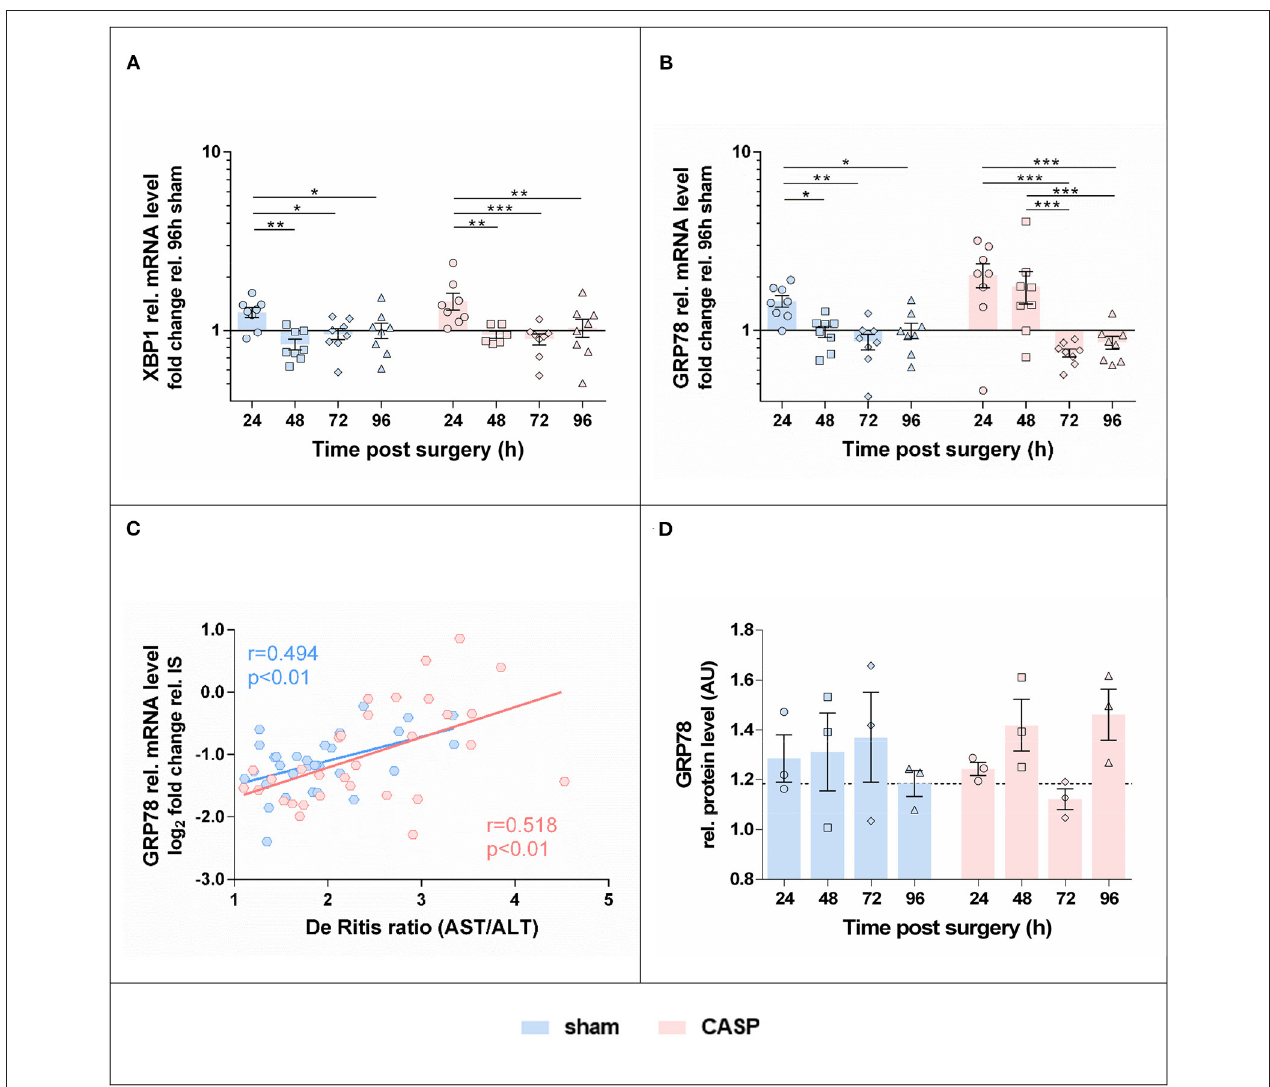
FIGURE 4 | Gene expression of UPR markers in the liver is highest at 24h after surgery. Gene expression levels of (A) XBP1 and (B) GRP78 in the liver of sham and CASP operated rats were determined by means of qPCR. Data are shown as mean ± SEM ( n = 8 per group). (C) Pearson correlation between GRP78 mRNA level and De Ritis ratio of sham ( n = 31) and CASP ( n = 31) operated animals. (D) GRP78 protein abundance in liver homogenates of single animals was analyzed by SDS-PAGE and immunostained for GRP78 (blot is shown in Supplementary Figure S1B ). Band intensities of specific staining were normalized to the total protein of the respective gel lanes. Values are given as mean AU (arbitrary units) ± SEM ( n = 3 per group). The dashed line indicates the mean value of the sham group at 96h. Statistical differences were calculated using two-way ANOVA followed by uncorrected Fisher’s LSD test and are indicated by * p < 0.05; ** p < 0.01, and *** p <